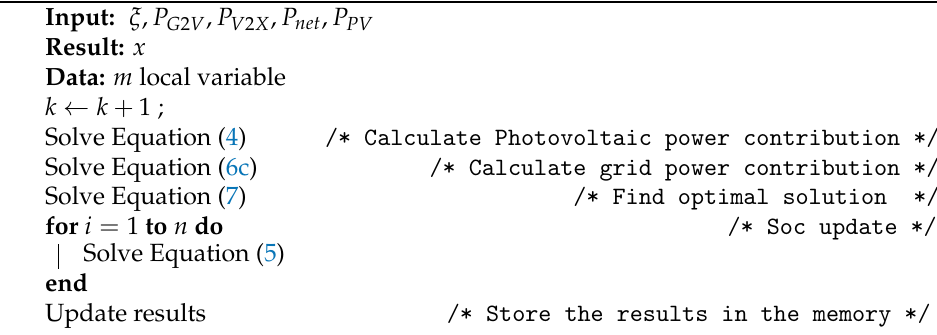
Algorithm 2: Pseudo-code of the proposed